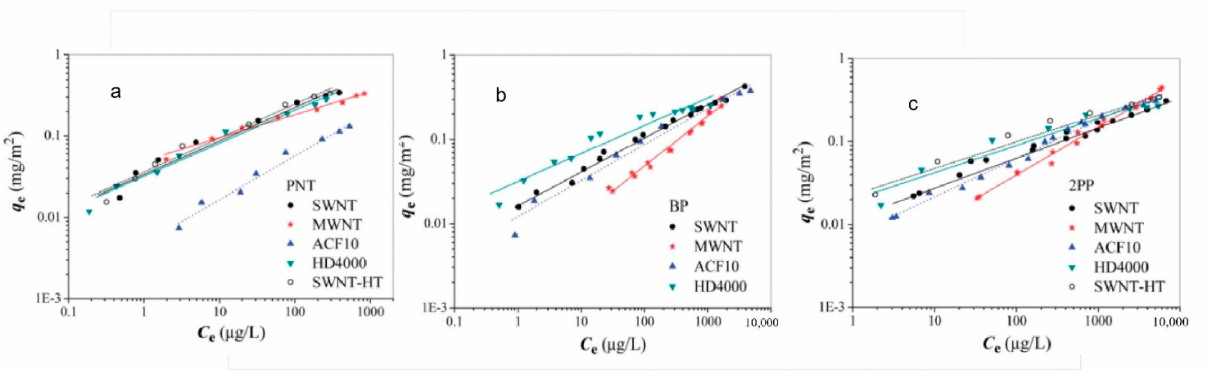
Figure 9. Adsorption isotherms of three organic aromatic compounds on different carbon materials [46]. Symbol: experimental data, line: linear fit of FM. (( a ) p-nitrotoluene PNT, ( b ) p-xylene BP, ( c ) phenylphenol